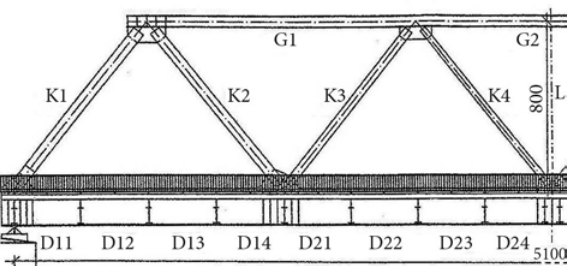
Fig. 2. Cross-section of railway bridge span with composite deck (concrete slab